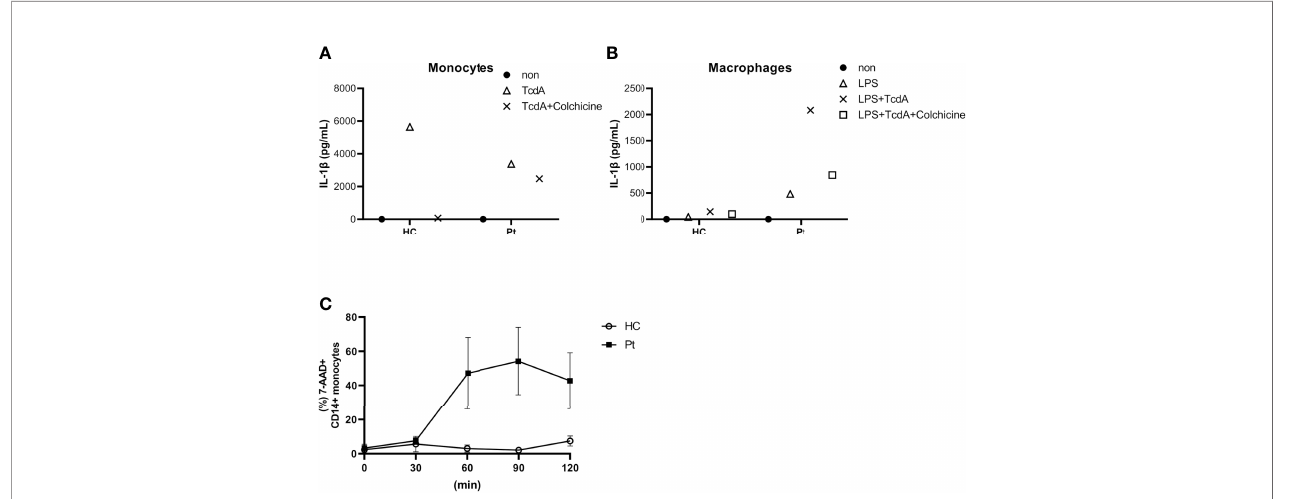
FIGURE 4 | (A) Interleukin 1 b (IL-1 b ) secretion from primary monocytes in response to Clostridium dif fi cile toxin A (TcdA) with or without colchicine. (B) IL-1 b secretion from LPS-primed monocyte-derived macrophages upon TcdA stimulation with or without colchicine. (C) Time course of UCN-01-induced monocyte cell death. Data were obtained from the patient (A/B; data from single experiment with technical duplicates for each condition, C; data from two independent experiments) and three healthy controls (HC).